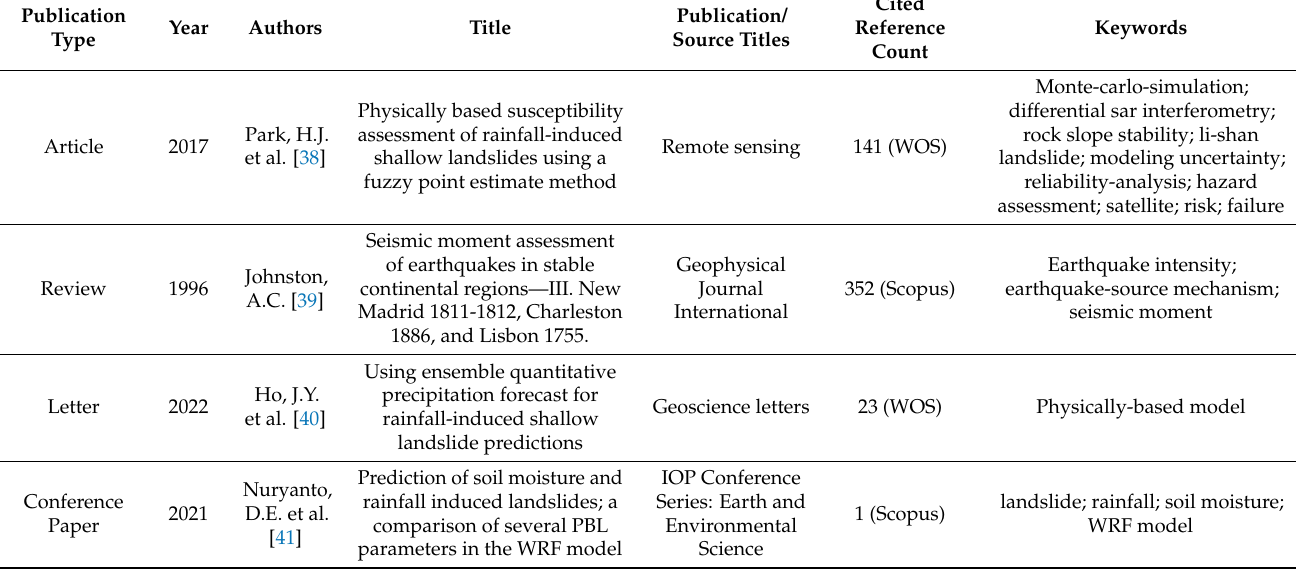
Table 1. Characteristics of the included